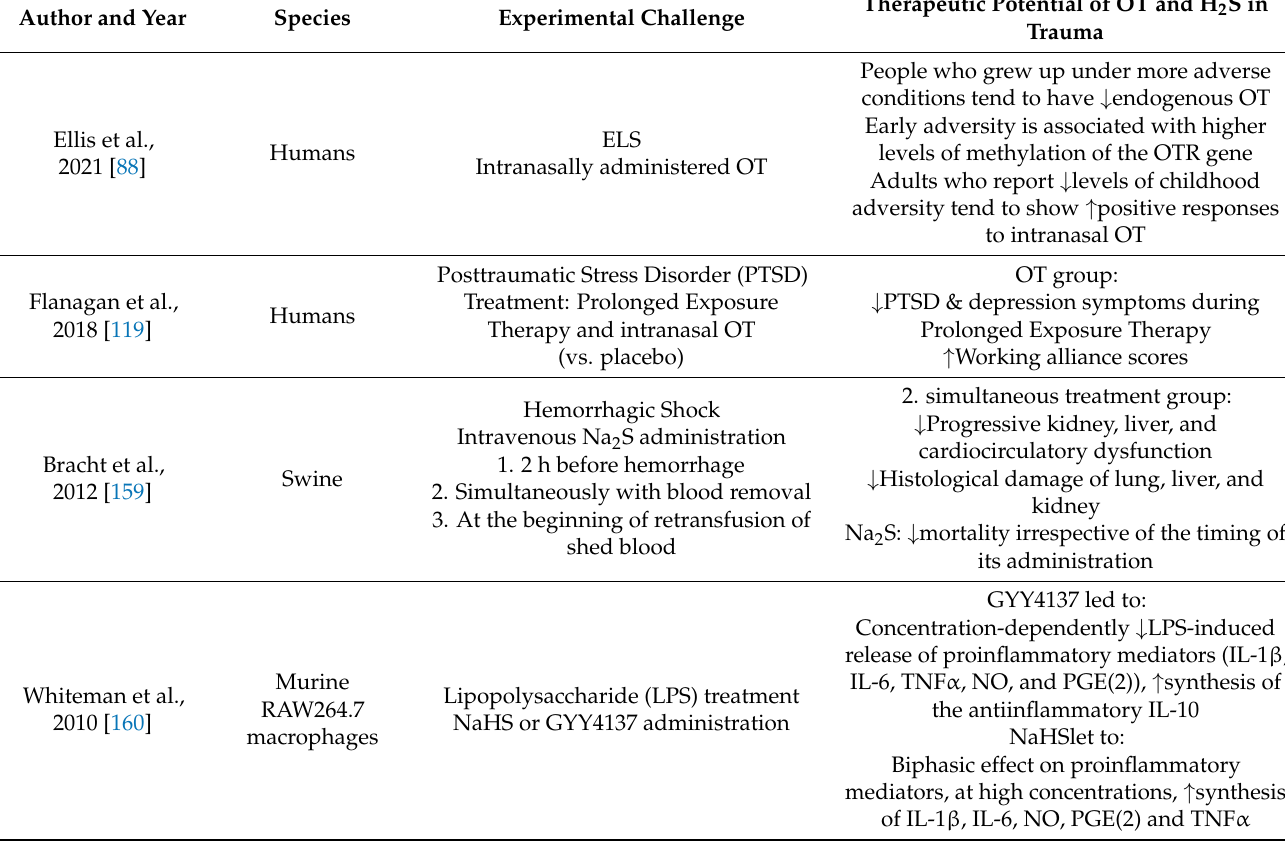
Table 2. Summary of studies: Therapeutic potential of the H 2 S system and the OT/OTR system in trauma. Author and